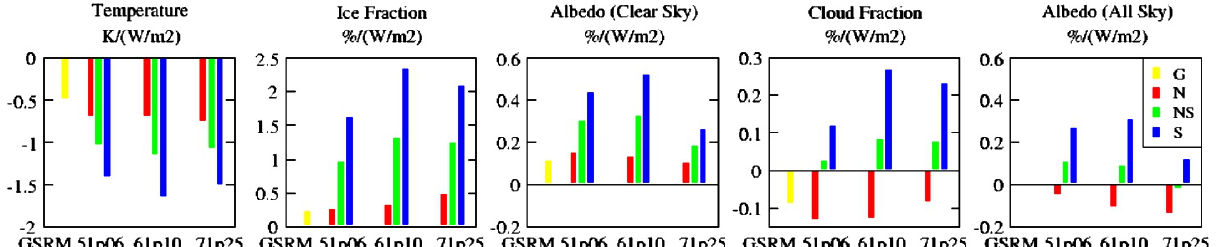
Fig. 9. Global mean changes in surface air temperature, ice fraction, TOA albedo for clear skies, cloud fraction, and TOA all-sky albedo, with each normalized by dividing by the reduction in solar forcing averaged over the globe. The yellow bars represent the results from the globally uniform reduction in solar insolation (G), the red bars from the northern high-latitude insolation reductions (N), the blue bars from the southern high-latitude insolation reductions (S), and the green bars from combined northern and southern high-latitude solar reductions (NS). For the three high-latitude reduction cases, incident solar radiation at the TOA was reduced by 6% poleward of 51 ◦ , 10% poleward of 61 ◦ , and 25% poleward of 71 ◦ .